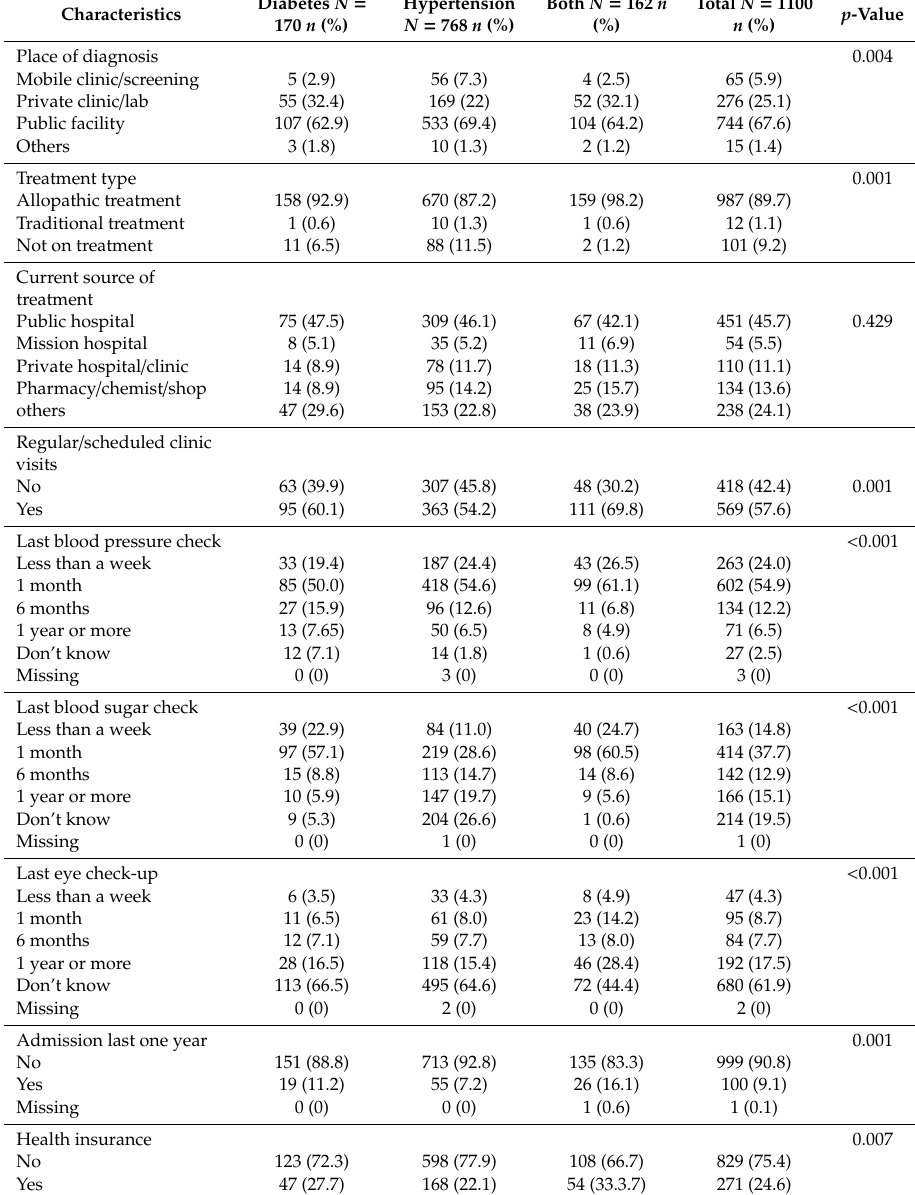
Table 2. Description of health-seeking behaviour of respondents by disease status.